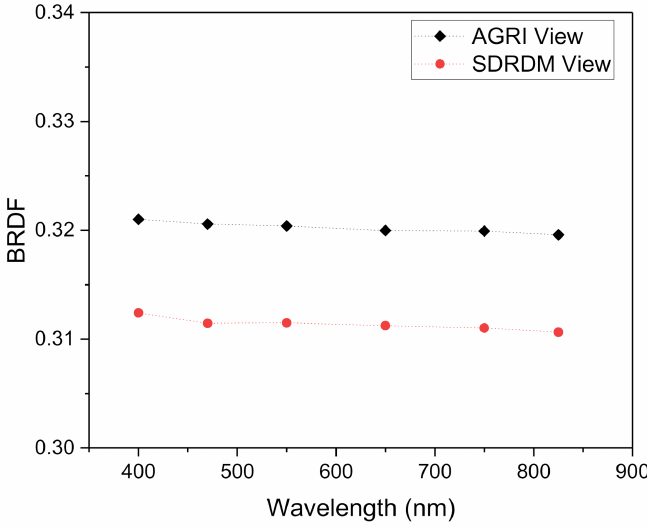
Figure 5. BRDF of the AGRI and SDRDM views with a fixed incident angle.